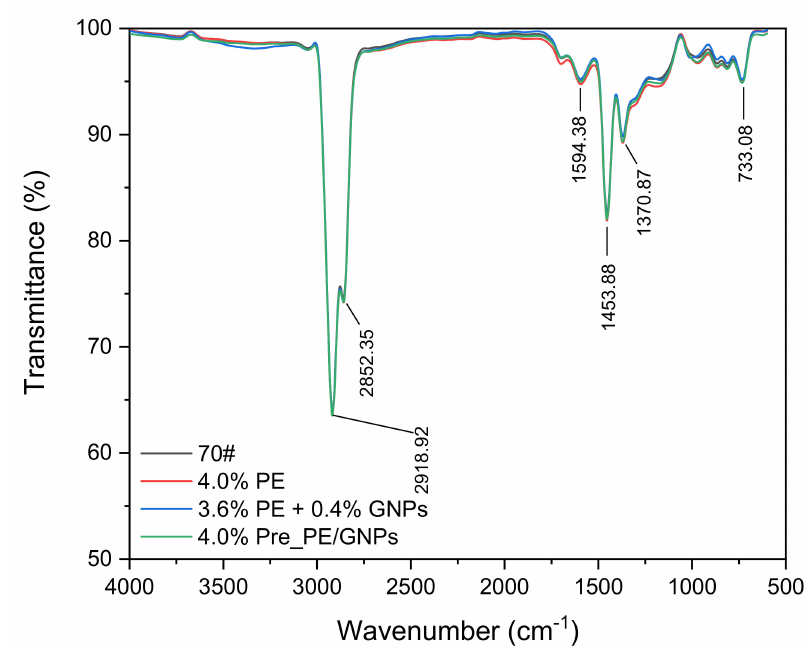
Figure 9. FT-IR spectra of asphalt binder